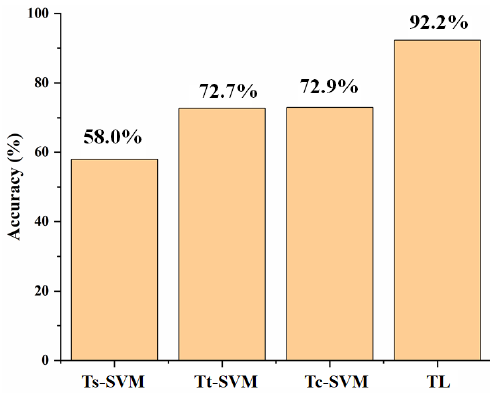
Figure 8. Accuracy comparison of the different methods. Ts-SVM and Tt-SVM represented SVM models trained by 520 samples from the source domain and 30 samples from the target domain, respectively; Tc-SVM represented the SVM model trained by the combination of Ts and Tt; TL represented the TrAdaBoost model based on SVM, and the training samples were consistent with Tc. The test samples for these four methods were the remaining target domain samples.